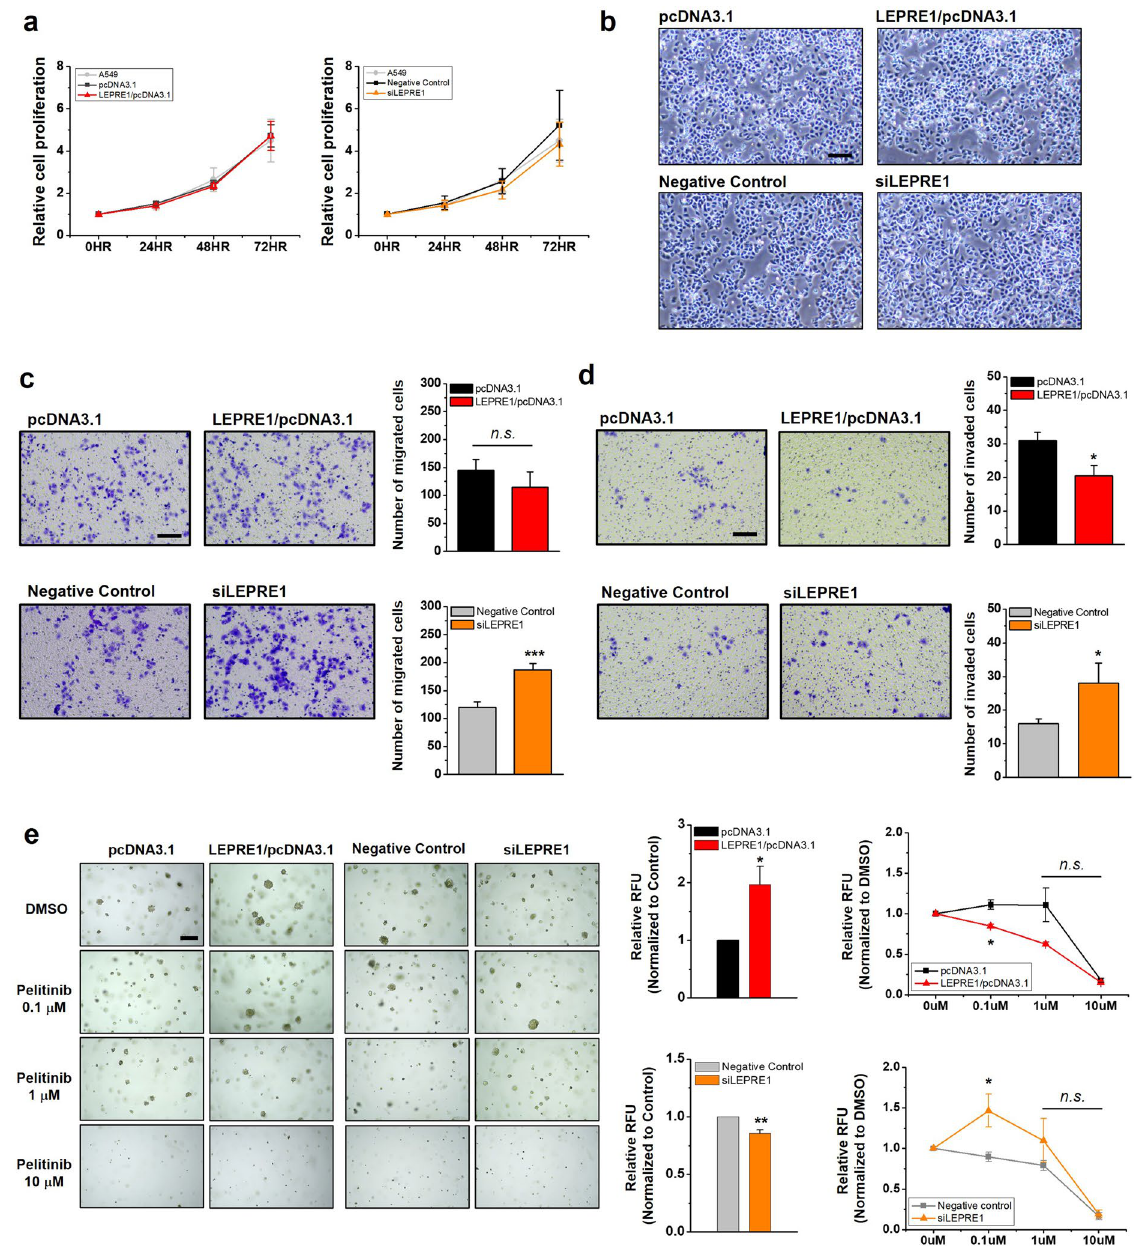
Figure 5. LEPRE1 affects cell morphology, migration/invasion, and colonization in lung cancer-derived A549 cells. (a ) Comparison of cell growth in parental or transfected (pcDNA3.1, LEPRE1/pcDNA3.1, Negative Control siRNA, or siLEPRE1) A549 cells. Equal numbers of cells were cultured in 96-well plates for 72 h. After the indicated time points, proliferation rates were analyzed using WST-1 proliferation assays. Error bars represent the SEM from three independent experimental replicates. ( b ) Comparison of cell morphology in transfected A549 cells (pcDNA3.1, LEPRE11/pcDNA3.1, Negative Control siRNA, or siLEPRE1). Scale bar, 800 μm. ( c , d ) Migration ( c ) and invasion ( d ) abilities of transfected A549 cells were evaluated using Transwell or Matrigel-coated Transwell plates, respectively. After 24 h, the migrated or invading cells were fixed, stained with crystal violet, and photographed. Representative images of Transwell inserts demonstrating stained migrating or invading cells are shown (left side). The relative migration or invasive abilities of the indicated cells are displayed in the bottom panel. Values shown are means ± SEMs from three independent experiments. Scale bar, 200 μm; n.s. not significant; * p < 0.05; *** p < 0.001. ( e ) Colony formation assays of transfected A549 cells treated with DMSO or the indicated concentration of pelitinib for 7 days. Representative images of colonies are shown (left side). The ability of transfected A549 cells to form colonies was normalized to the control cells, which are shown in the middle negative control column. Responsiveness to pelitinib treatments was normalized to each corresponding DMSO control (right side). Scale bar, 200 μm. Data are presented as the mean ± SEM of three independent experiments. n.s. not significant; * p < 0.05; ** p <